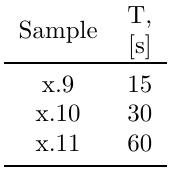
Table 4. Parameters of AAT.